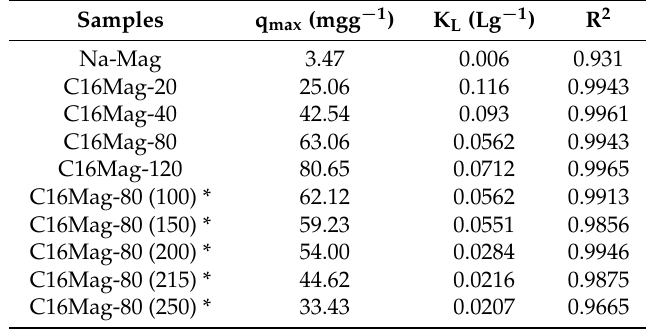
Table 3. Langmuir parameters for the removal of eosin by different organo-magadiites.